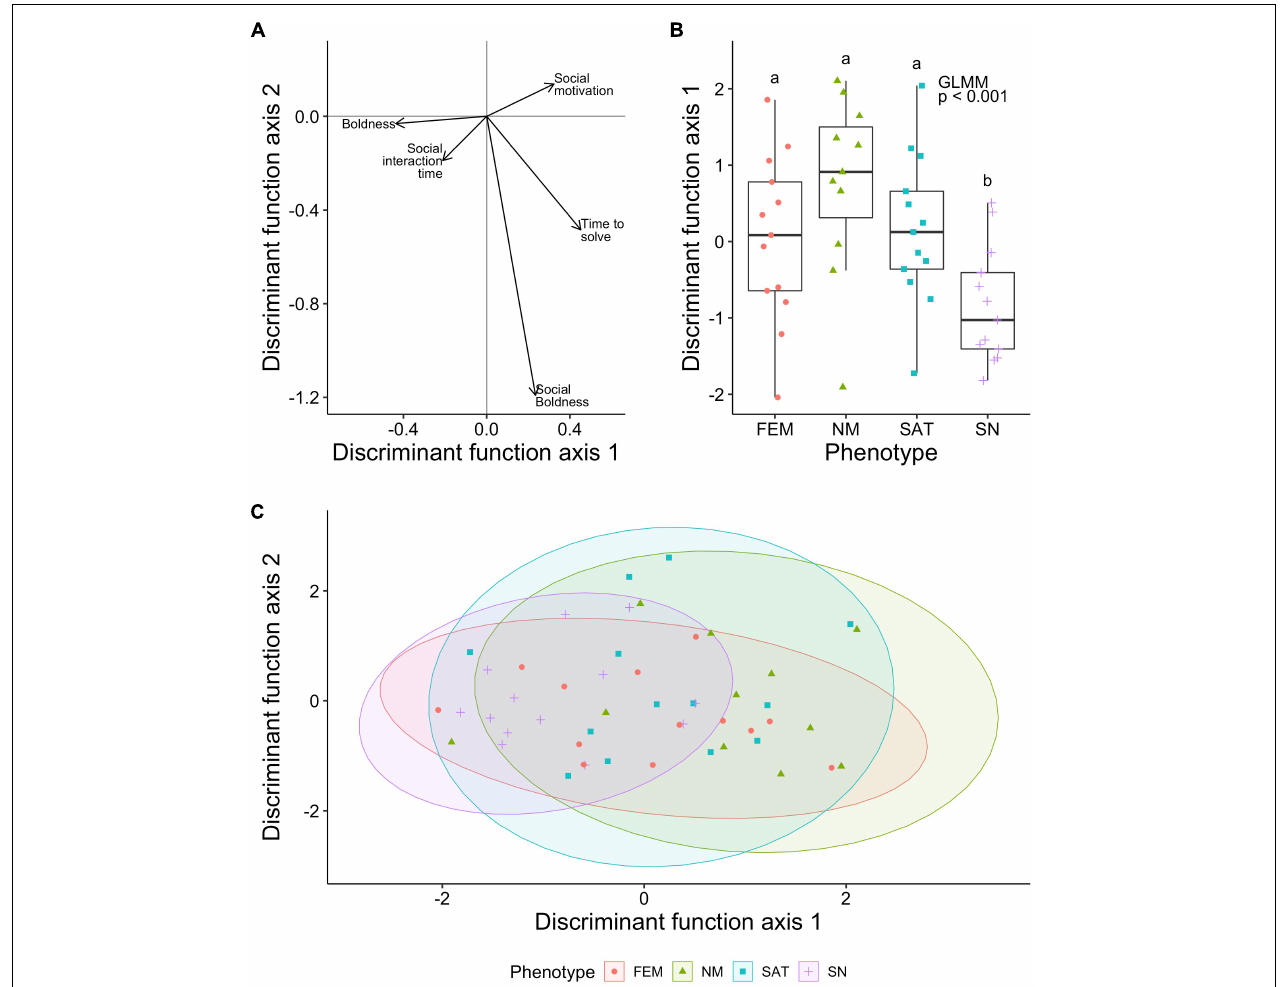
FIGURE 4 | Cognitive-behavioral profiles differ by phenotype. (A) Loadings of the 5 input metrics into a discriminant function analysis onto the two primary axes. (B) Boxplot of the DFA axis 1 scores by phenotype along with GLMM results. Sneaker males significantly differed from the rest of the phenotypes, p < 0.001. Letters above box plots indicate statistical outcomes of tukey contrast analyses with sneaker males being different than all other phenotypes. (C) Plotting the first two axes of the DFA grouped by phenotype. Ellipses represent the 95% confidence intervals for each